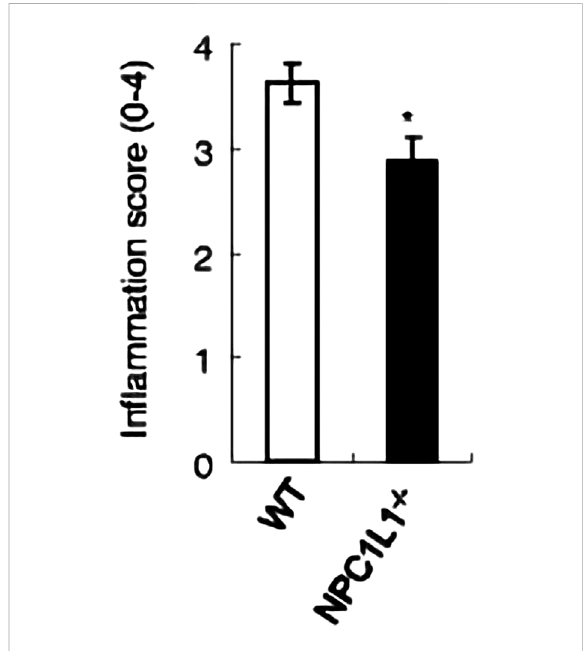
NPC1L1-knockout mice have signi fi cantly lower intestinal in fl ammation scores than wild-type mice (He et al., 2015).